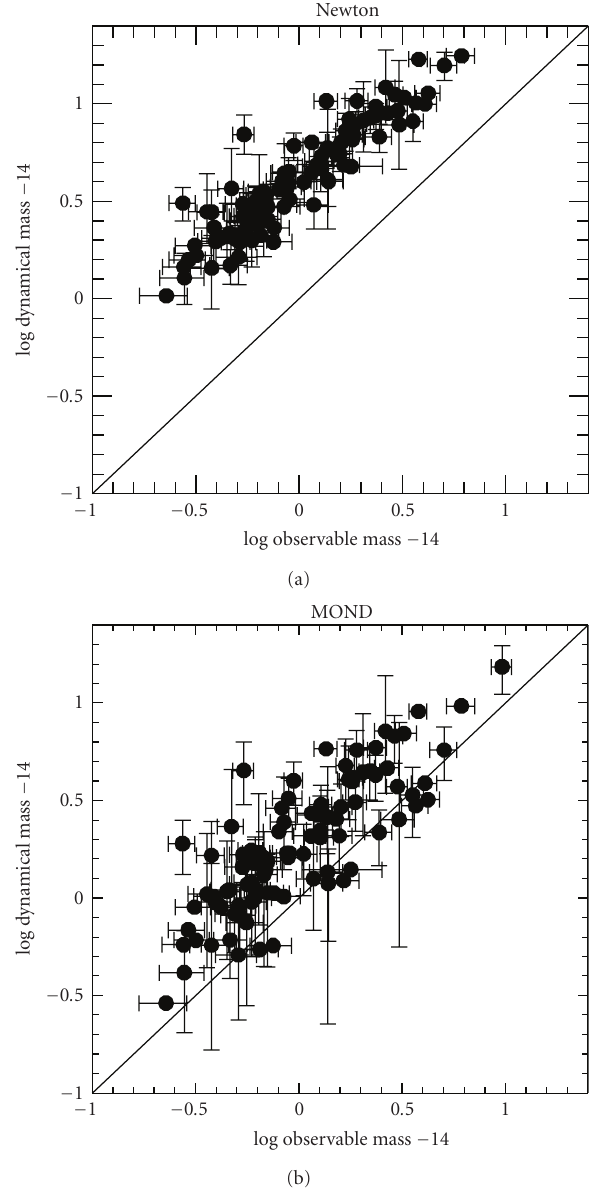
Figure 7: (a) The Newtonian dynamical mass of clusters of galaxies within an observed cuto ff radius ( r out ) versus the total observable mass in 93 X-ray emitting clusters of galaxies. The solid line corresponds to M dyn = M obs (no discrepancy). (b) The MOND dynamical mass within r out versus the total observable mass for the same X-ray emitting clusters